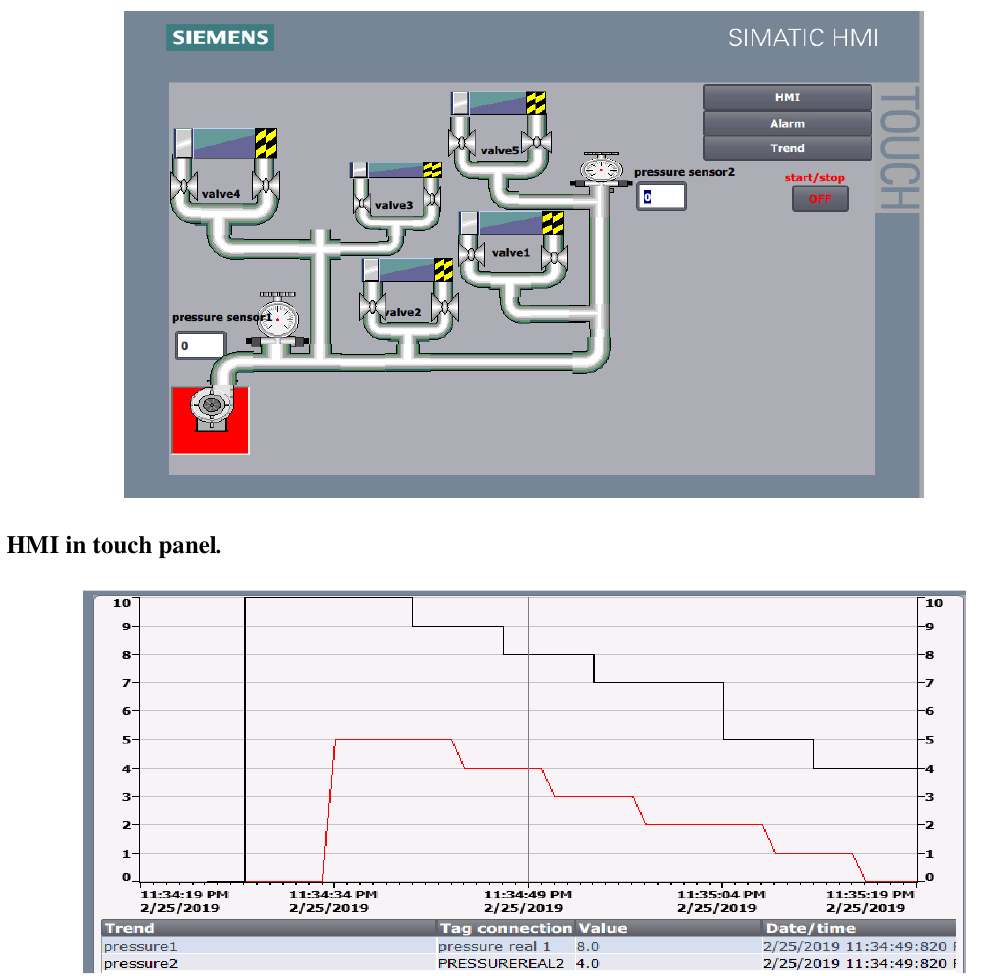
Moreover, the analog alarm would be showed as well if the pressure in pipes was higher than desired value, as shown in figure (13).